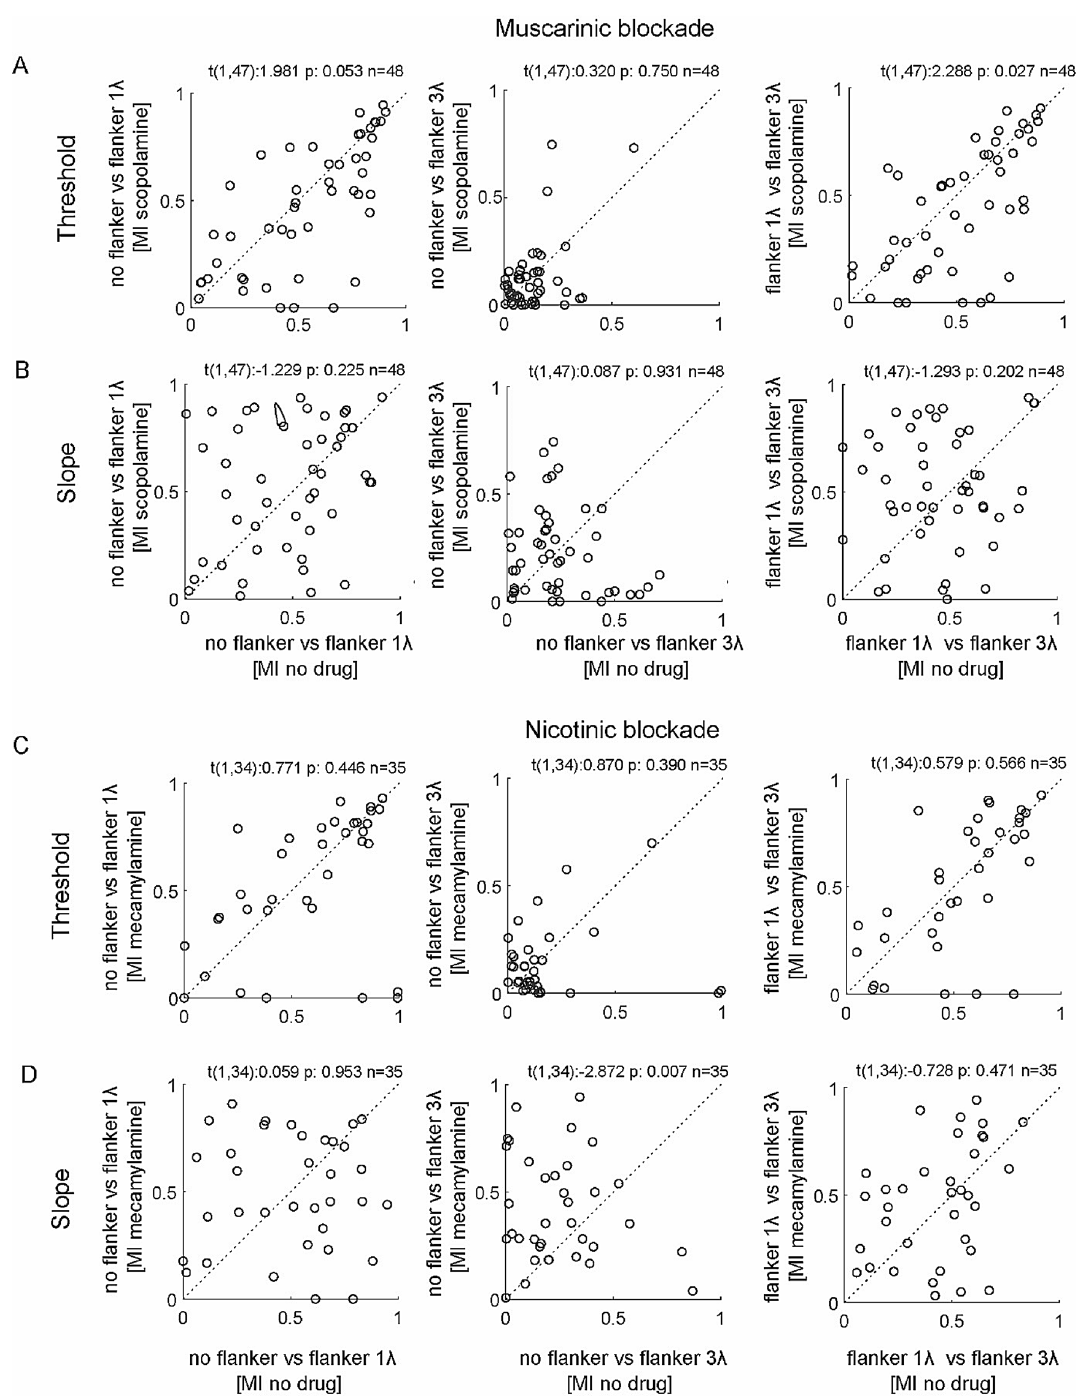
Figure 7. Effect of muscarinic and nicotinic blockade on flanker induced modulations of neuronal thresholds and slopes of contrast sensitivity function. ( A ) Scatterplot of threshold absolute values of modulation indices (MI) in the no drug condition (x-axis) against threshold absolute values of modulation indices (MI) for in the scopolamine applied condition (y-axis). Left column shows MIs for the no flanker versus flanker of 3λ condition, middle shows MIs for the no flanker versus flanker of 1λ condition, and right column shows MIs for the flanker of 3λ condition versus flanker of 1λ condition. Insets show paired t-test statistics. ( B ) Same as A but for absolute MIs for slope values. ( C,D ) Same as A and B , but with mecamylamine as drug